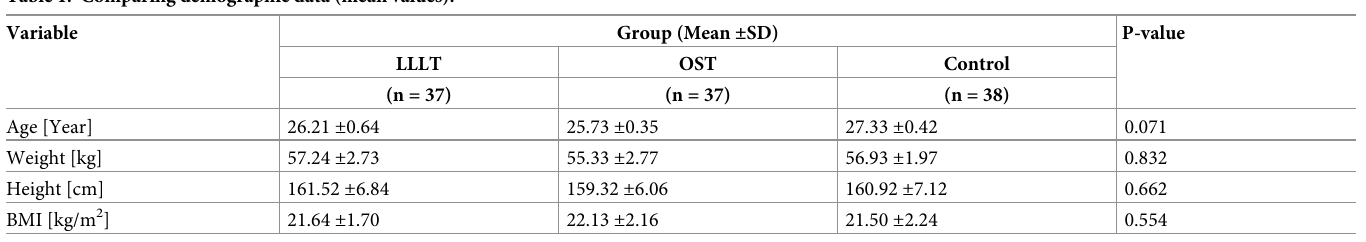
Table 1. Comparing demographic data (mean